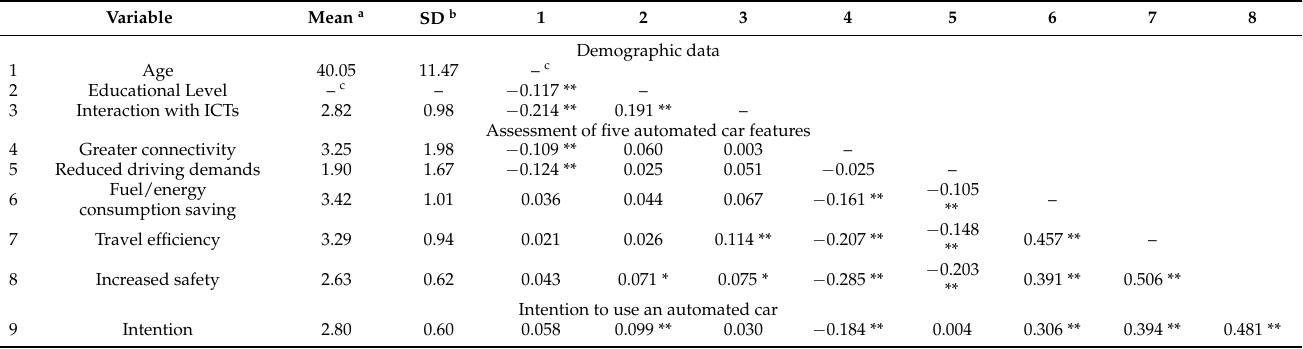
Table 2. Basic descriptive data and bivariate (Spearman’s rho ) correlations between study